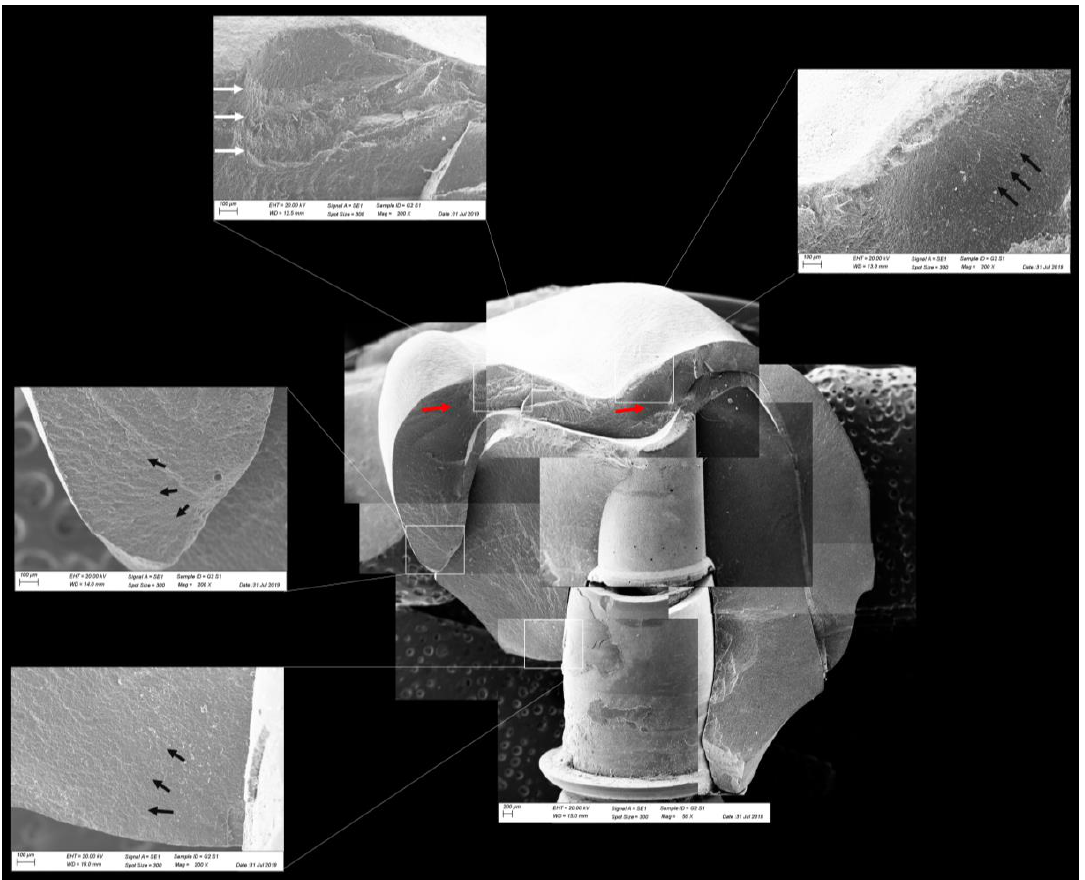
Figure 12. Fractographic analysis of a representative specimen from the CME group. The mesostructure failed without the involvement of the crown. The black arrows indicate the hackle lines, the white arrows indicate the arrest lines, and the red arrows indicate compression curls.